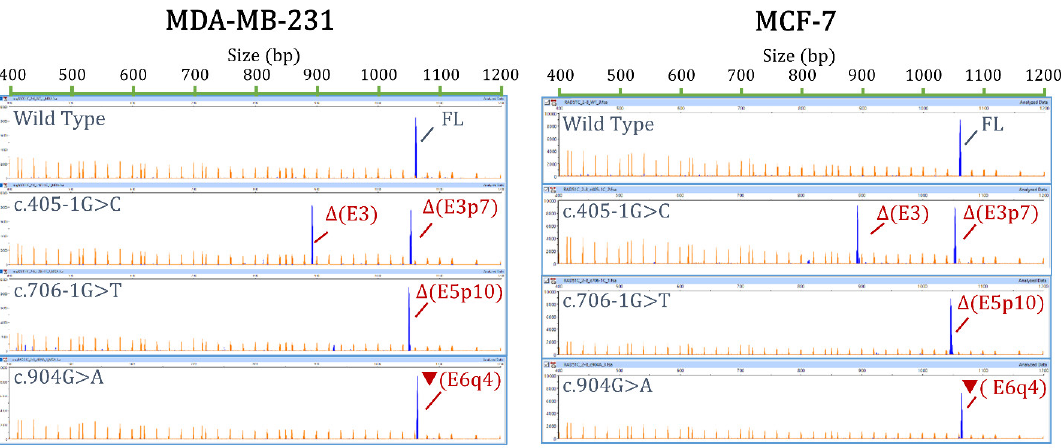
Figure 2. Reproducibility of splicing assays in MDA-MB-231 ( left ) and MCF-7 ( right ) cells. The wild-type and mutant minigenes of c.405-1G>C, c.706-1G>T, and c.904G>A were tested in MCF-7 and MDA-MB-231 cells. RT-PCR products were run on agarose gels.